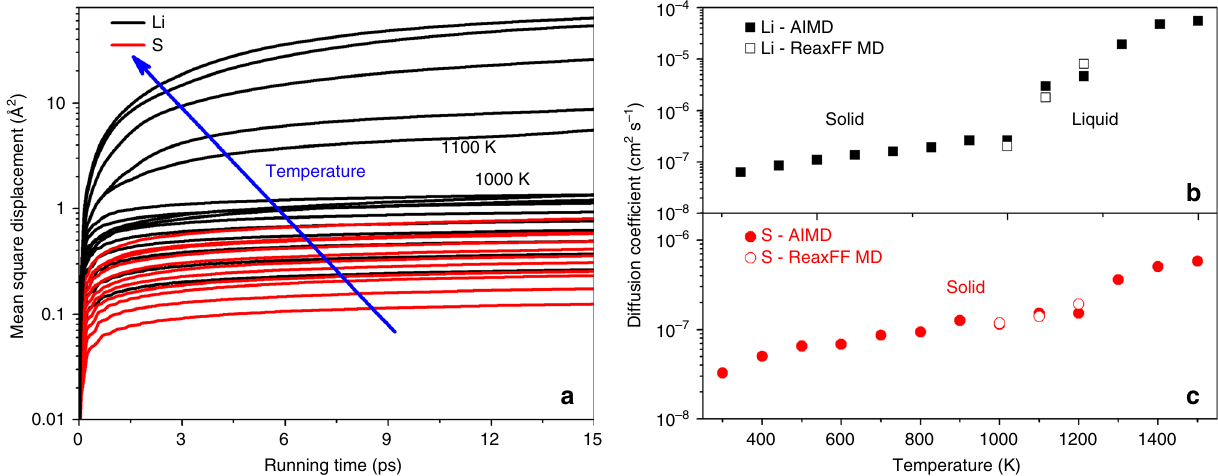
Fig. 1 Diffusion coef fi cient calculations. a Mean square displacement and diffusion coef fi cient of b Li and c S at different temperatures obtained by ab initio molecular dynamics (AIMD) simulations and reactive force fi led molecular dynamics (ReaxFF MD) simulations. The arrow indicates the increase